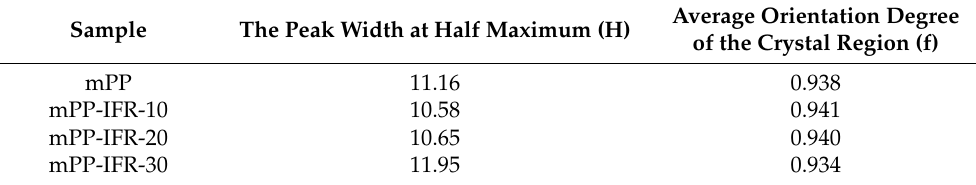
Figure 5. The 2D-WAXD of mPP fiber ( a ), mPP-IFR-10 fiber ( b ), mPP-IFR-20 fiber ( c ), and mPP-IFR-30 fiber ( d ). Table 3. The 2D-WAXD data of the fibers.